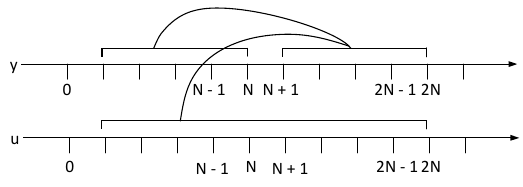
Figure 4. Step 2: Output prediction.